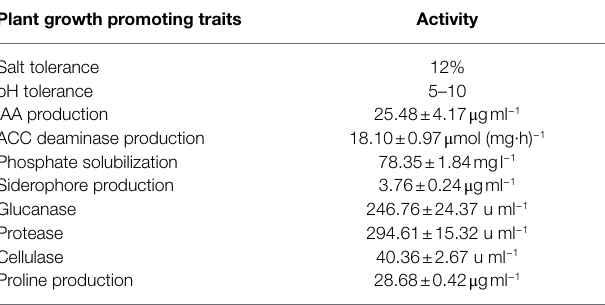
TABLE 1 | Plant growth promoting traits of JC-K3. Plant growth promoting traits